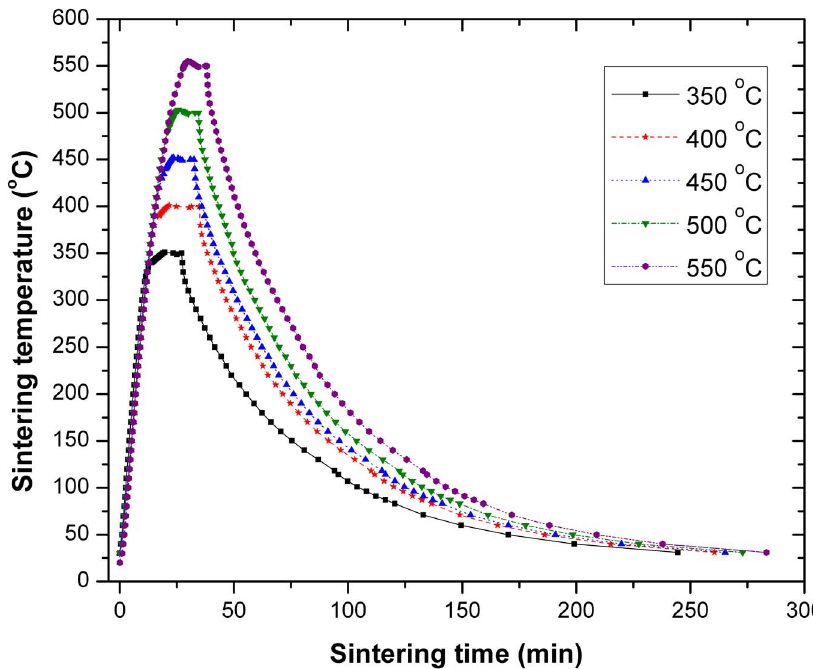
Figure 1. The photoanode sintering temperature as a function of time.